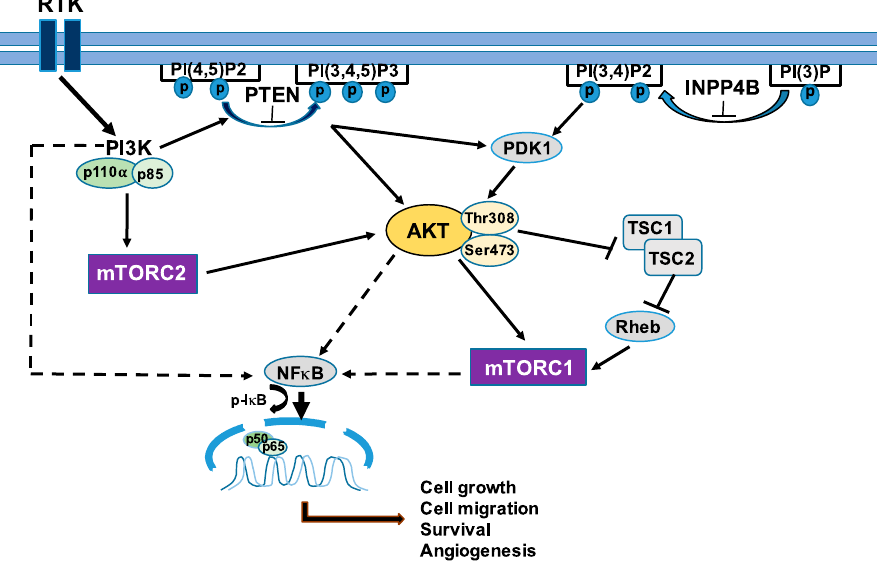
Figure 2. The phosphatidylinositol 3-kinase (PI3K)/AKT/mammalian target of rapamycin (mTOR)/nuclear factor- κ light chain enhancer of activated B cells (NF- κ B) pathway. Activation of this pathway leads to enhanced cell growth, migration, survival, and angiogenesis. Indirect activation was shown by dashed